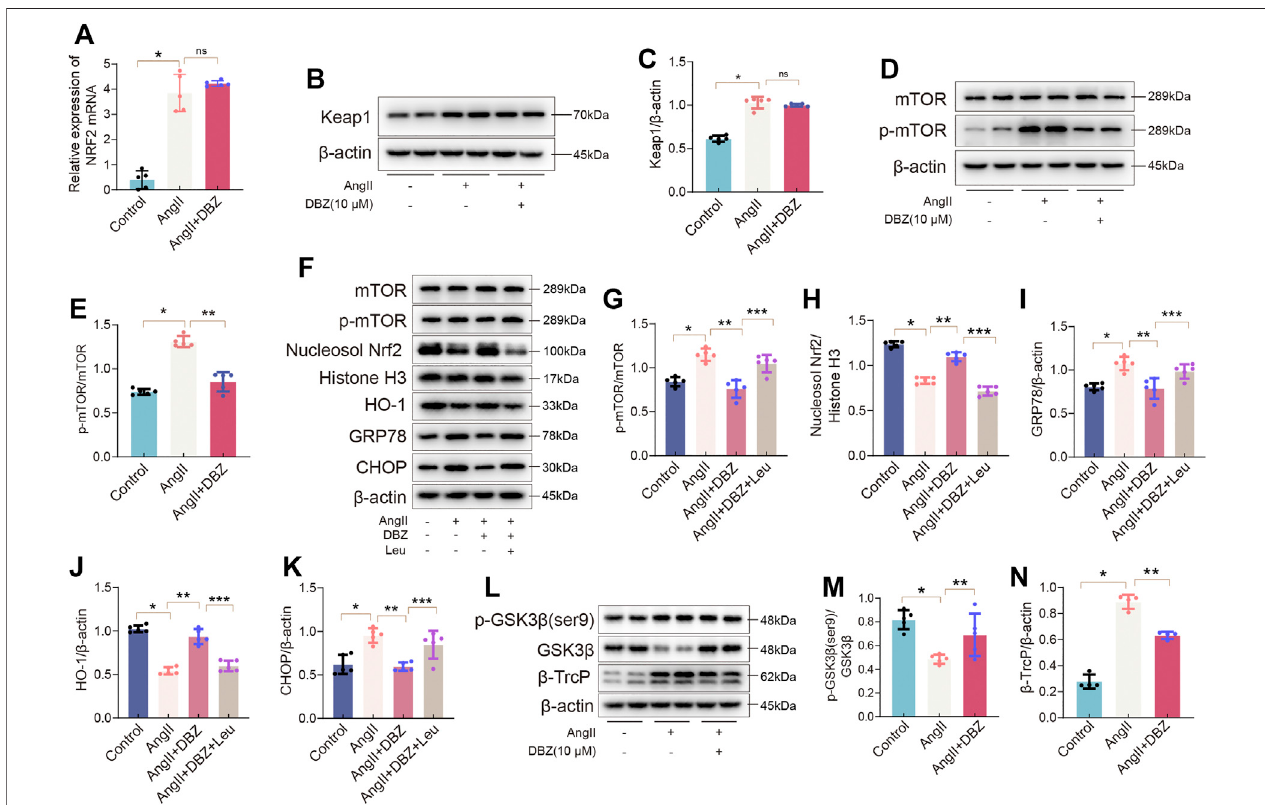
FIGURE9| DBZinhibitedthedegradation ofNrf2viathemTOR/ β -TrcPpathway. (A) Real-time PCRquanti fi cationofrelative mRNAexpression levelofNrf2. n =5. (B,C) Representative Westernblotting assay and quanti fi cation of Keap1. n =5. (D,E) Representative Western blotting assayand quanti fi cation ofp-mTOR and mTOR. n = 5. (F – K) Representative Western blotting assay and quanti fi cation of mTOR, p-mTOR, nucleosol Nrf2, Histone H3, HO-1, GRP78, and CHOP expression. n = 5. (L – N) Representative Western blotting assay and quanti fi cation of p-GSK3 β (ser9), GSK3 β , and β -TrcP expression. n = 4. * p < .05 compared with the Control group, ** p < .05 compared with the Ang II group, *** p < .05 compared with the Ang II + DBZ group. Results are expressed as means ± SD. Statistical analyses were performed by one-way ANOVA followed by Bonferroni ’ s post-hoc